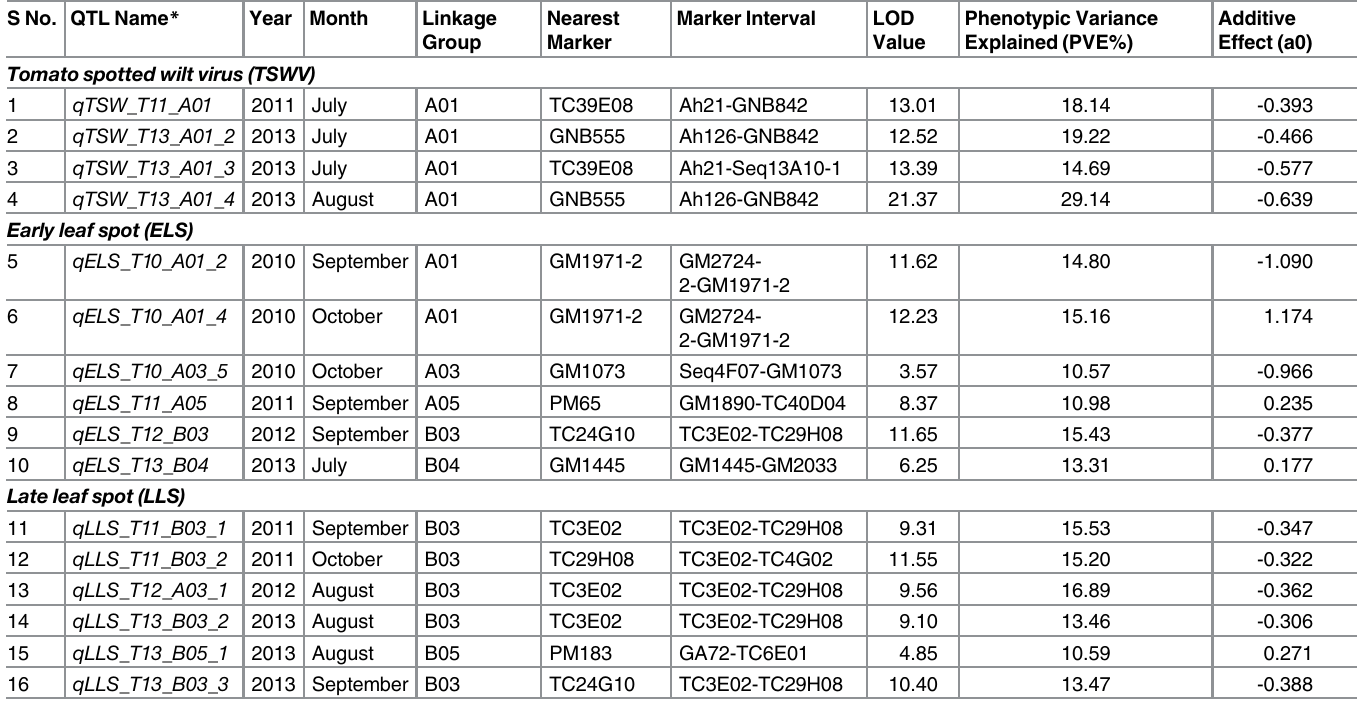
Table 3. Details of the major effect QTLs identified for TSWV, ELS and LLS resistance in S-population.